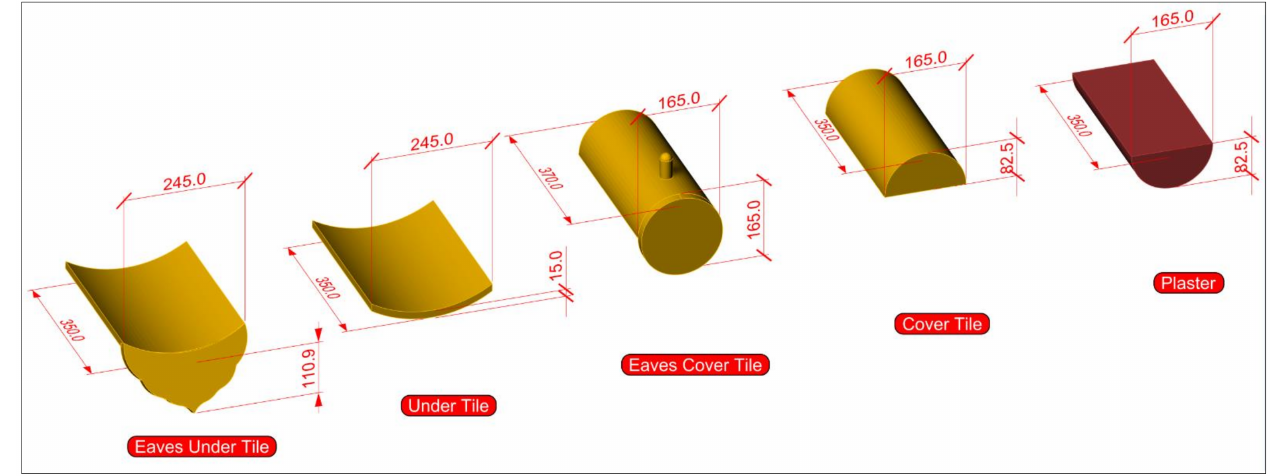
Figure 6. Five block instances of prototype